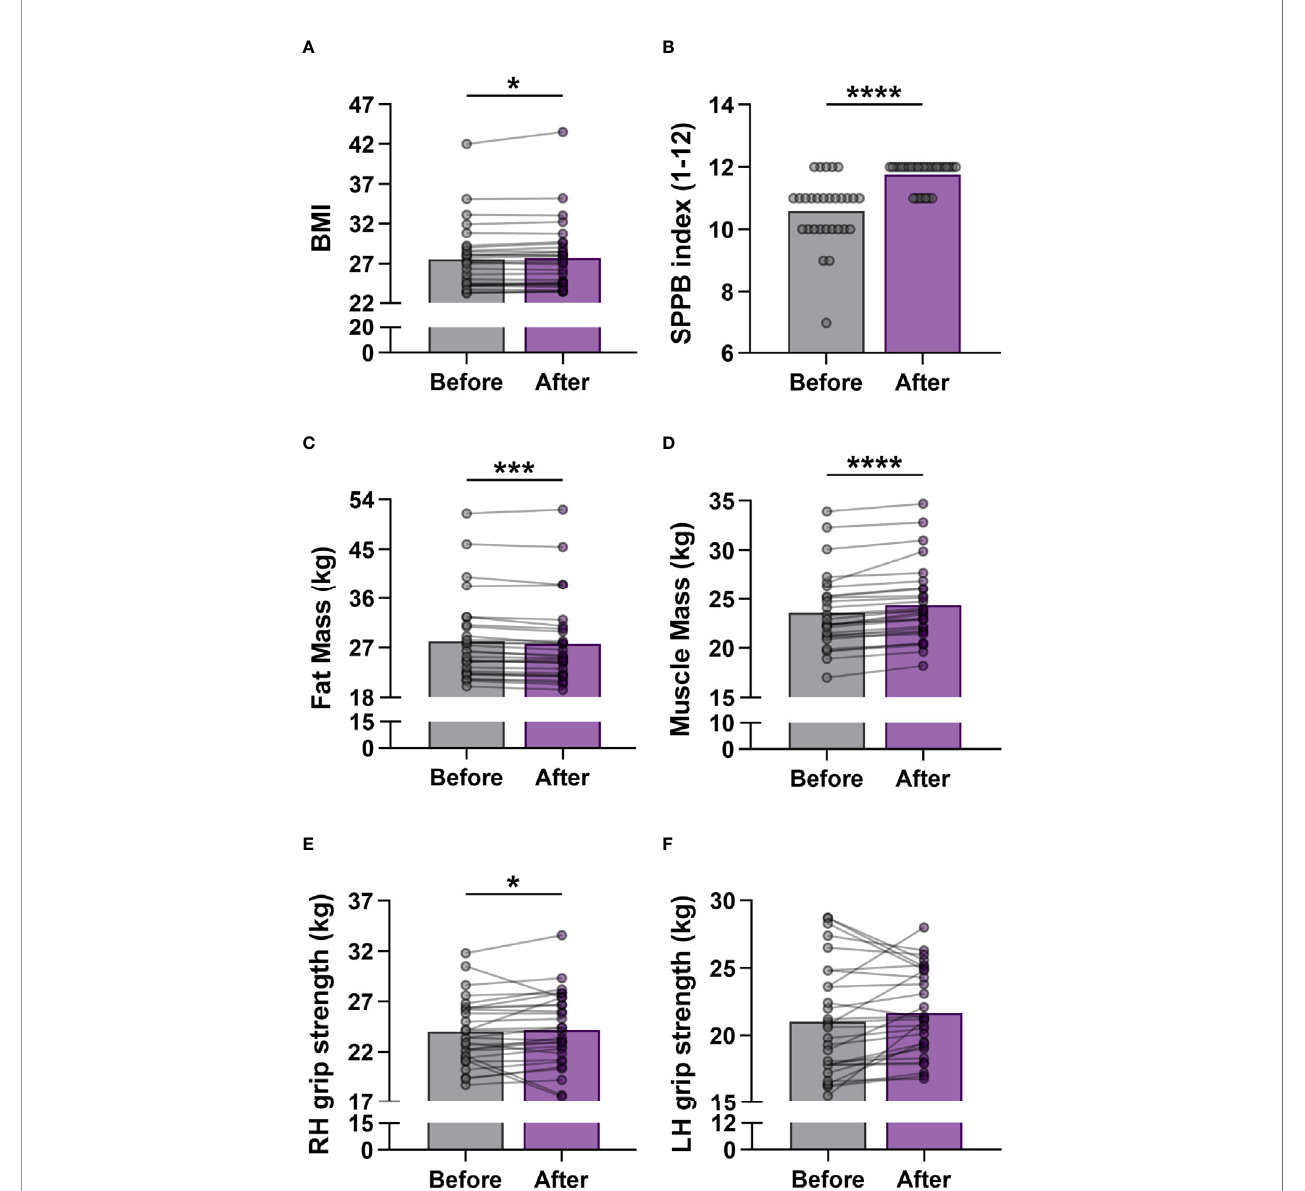
FIGURE 1 | Measurement of physical activity in elderly women before and after the exercise training program. (A) Body Mass Index (BMI). (B) Short Physical Performance Battery (SPPB) index. The scores range from 0 (worst performance) to 12 (best performance). (C) Mass of body fat. (D) Mass of skeletal muscle. (E) Right hand (RH) grip strength. (F) Left hand (LH) grip strength. Values were calculated in kilogram (kg). Wilcoxon matched pairs test was used. Each data point represents an individual subject. Bars show the mean values. Statistically signi fi cant differences are indicated by *p < 0.05; ***p < 0.001; ****p <